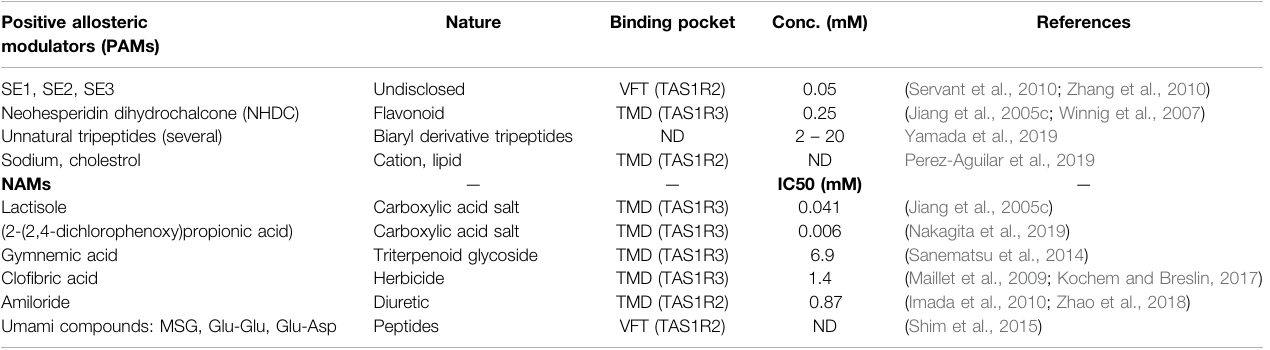
TABLE 4 | Sweet taste receptor ’ s positive allosteric regulators with concentration (used in cell based assays in studies) and negative allosteric modulators with their IC50 values. Positive allosteric modulators